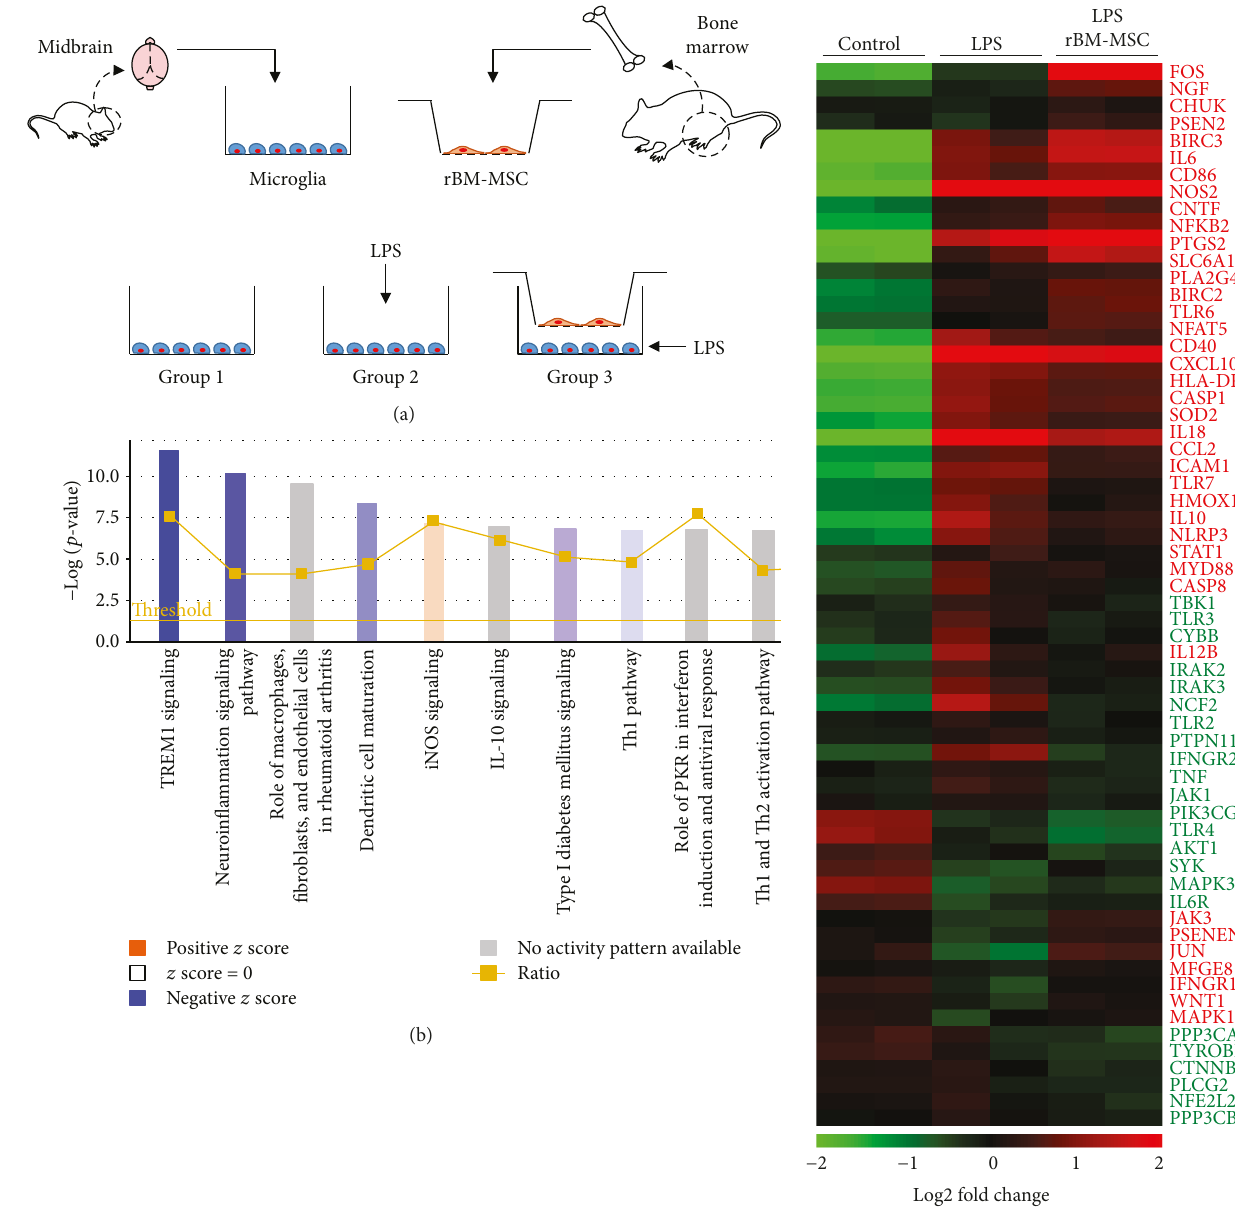
Figure 4: In fl ammation-related gene expression variation in LPS-stimulated microglia cocultured with rat bone marrow-derived mesenchymal stem cells (rBM-MSCs). (a) In vitro reverse coculture experimental design. Three di ff erent conditions were used (group 1 – 3): group 1, control (microglia only); group 2, LPS-stimulated microglia; and group 3, LPS-stimulation with rBM-MSC coculture. (b) Canonical pathway analysis was constructed algorithmically using Ingenuity Pathway Analysis based on microarray data. Bars indicate canonical pathways containing genes with signi fi cantly altered expression. Bar graph colours from blue (inhibition) to orange (activation) represent gene activity of the corresponding pathway according to z -score. (c) Heat map of genes related to in fl ammation with altered expression levels. Gene expression values are coloured from green (downregulated) to red